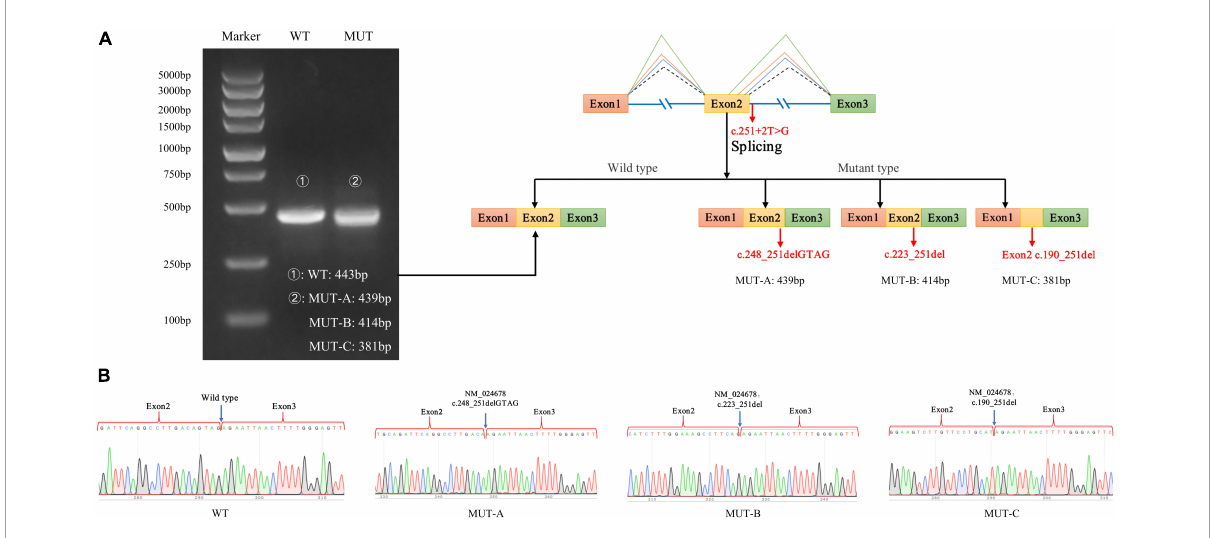
FIGURE5 Minigene experiment results of the NARS2 mutation c.251 + 2T > G. (A) Electrophoresis results of RT-PCR products of wild-type and mutant NARS2. The mutation plasmid c.251 + 2T > G produced three mRNA products, which were differentiated by cloning and sequencing because of the close distance between bands; (B) Sanger sequencing results of corresponding bands of wild-type and three mutant